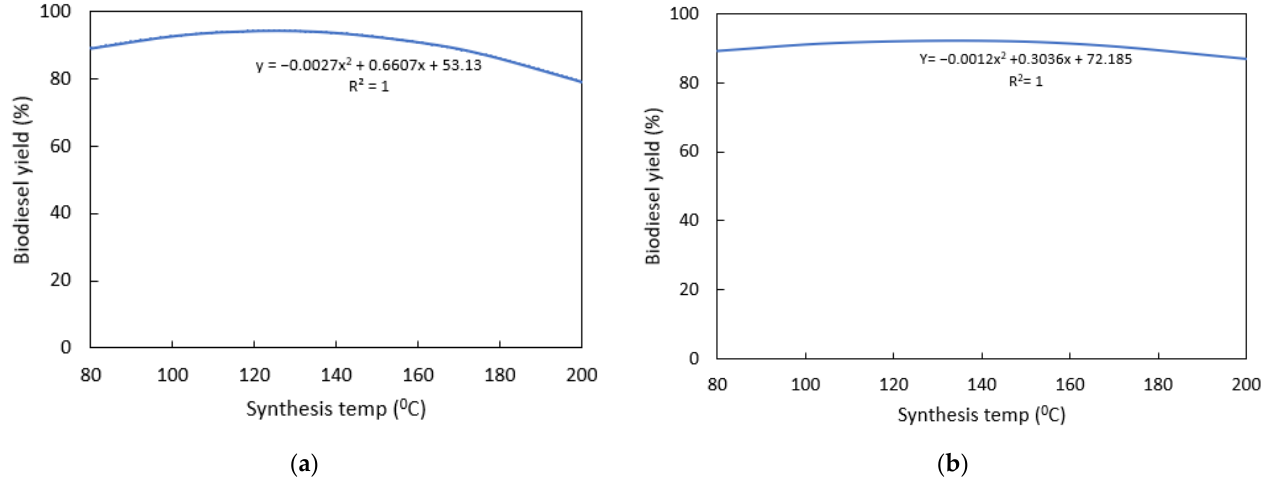
Figure 8. Effects of synthesis temperatures on biodiesel yield: ( a ) NaOH/CA; ( b ) CaO/CA.